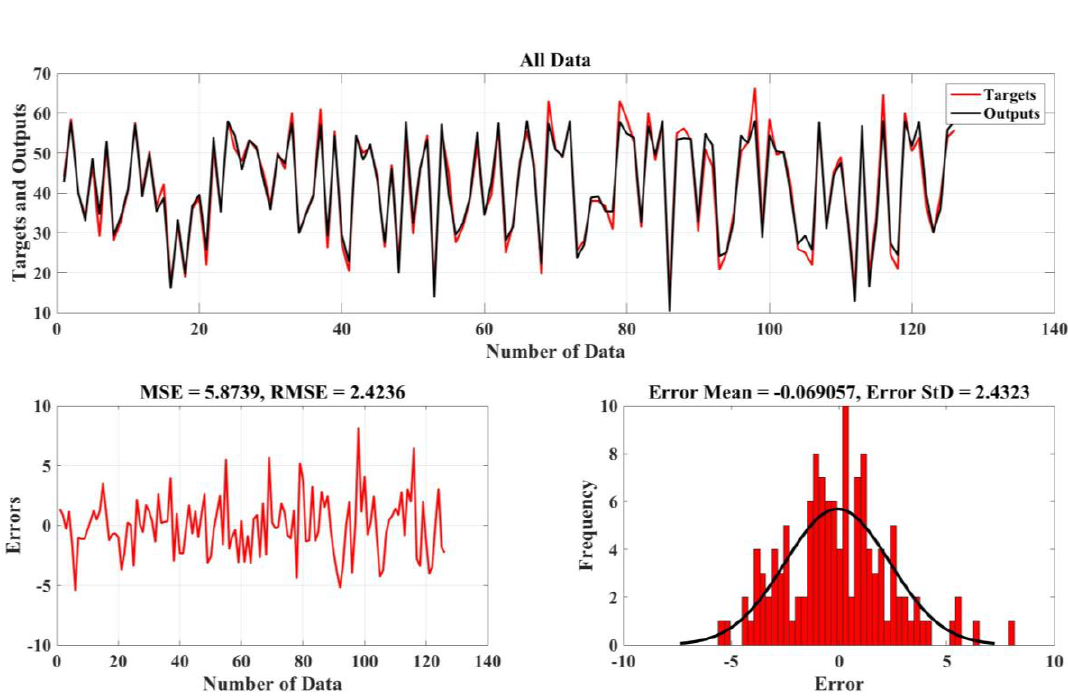
Fig.4. Results of the test data.